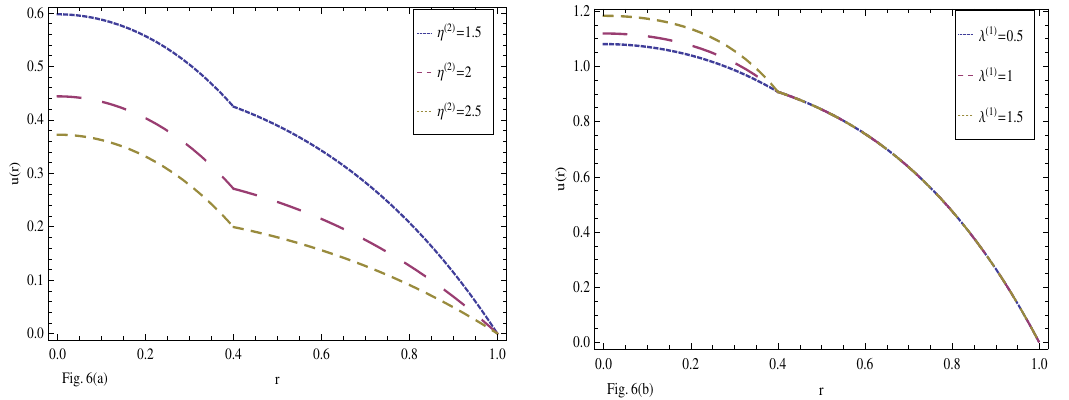
Figure 6. The effect of ( a ) η ( 2 ) and ( b ) λ ( 1 ) on the velocities of the two fluids.